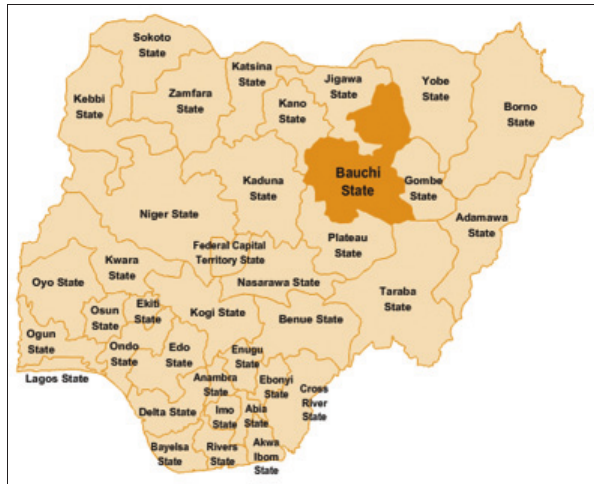
Figure-1: Map of Nigeria showing Bauchi State among the 36 State of the Federation (Source Wikipedia 2014).